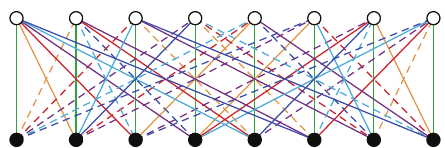
Figure 9: Standard form valise Adinkra.